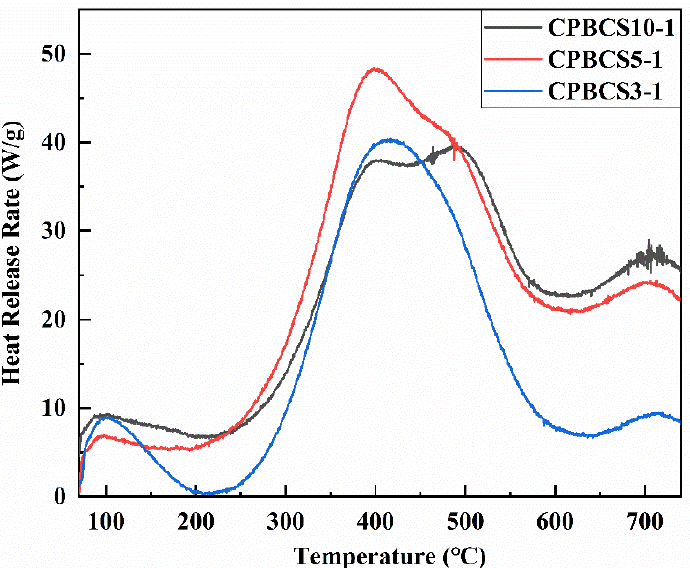
Figure 8. Heat release rate versus temperature in pyrolysis combustion flow calorimetry (PCFC) tests.